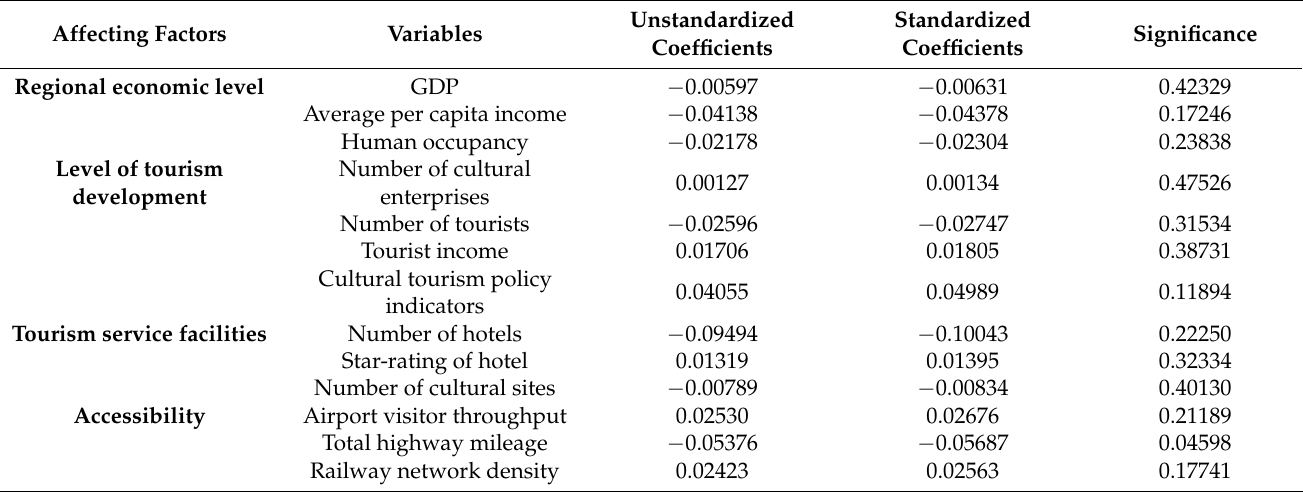
Table 5. QAP regression coefficients and test